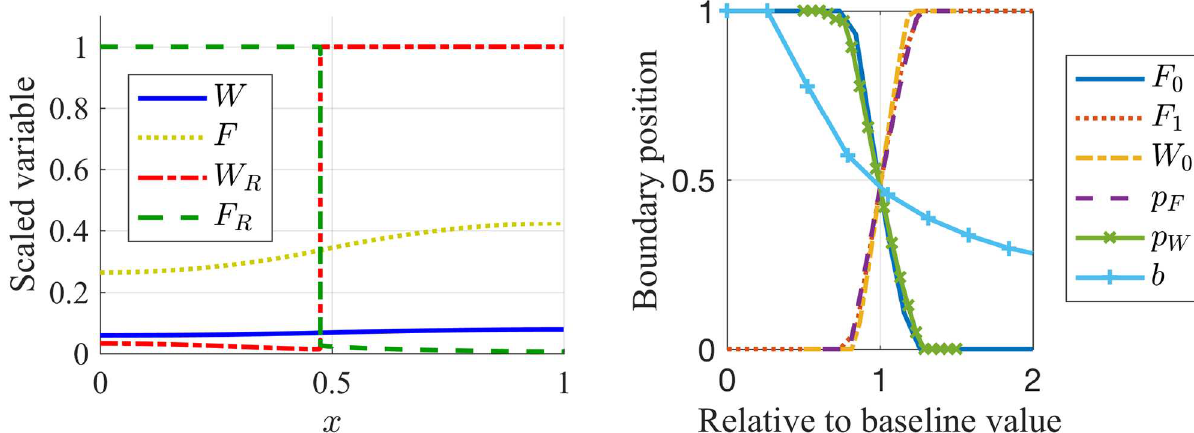
Fig 6. The position of the boundary between leading and trailing zones is parameter dependent. In the left panel, the concentration profiles of the ligandand receptoractivity are plotted at t = 25 minutes (after formation of signallingdomains), which revealsthe formation of a sharp boundarybetweenthe leading and trailing zones. In the right panel, the boundaryposition betweenthe leadingand trailingzones is shown to be a function of model parameters. Parameter sweeps were conductedfor a range of “IC 50 ” inhibitionparameters F 0 , W 0 , FGF steady state receptorlevels F 1 , productionof Wnt and FGF ligand p W , p F , as well as the slope of the W 1 gradientacross the PLLP, b . The vertical axis representsthe fraction of the PLLP length that is FGF-receptor expressingat steady state. The horizontal axis represents the given parameters, scaled by their baselinevalues as listed in Table A in SupportingInformation S6 Text. Parameter Estimation and